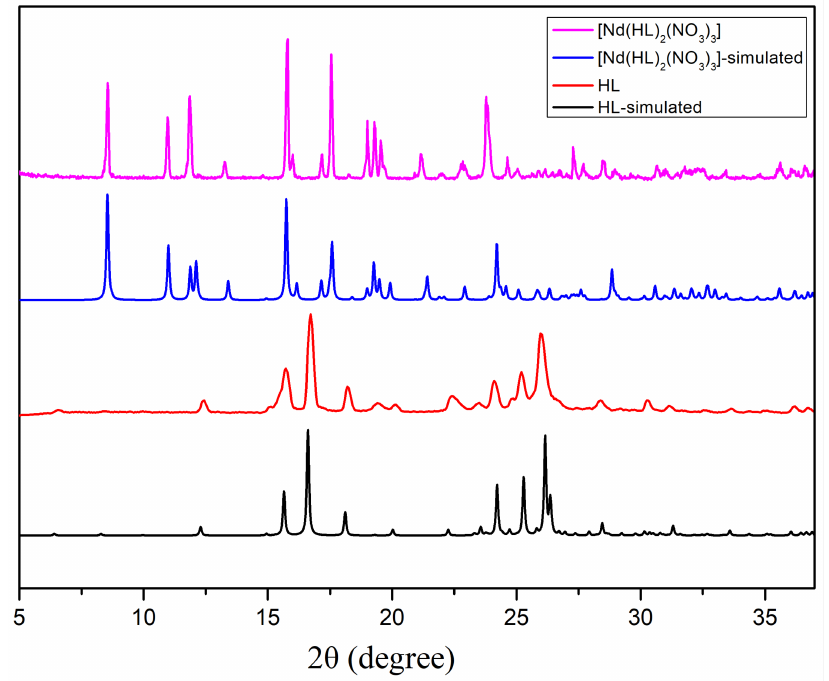
Figure 2. PXDR patterns of the synthesized [Nd(HL) 2 (NO 3 ) 3 ] and ligand HL in comparison with the simulated patterns from single crystal